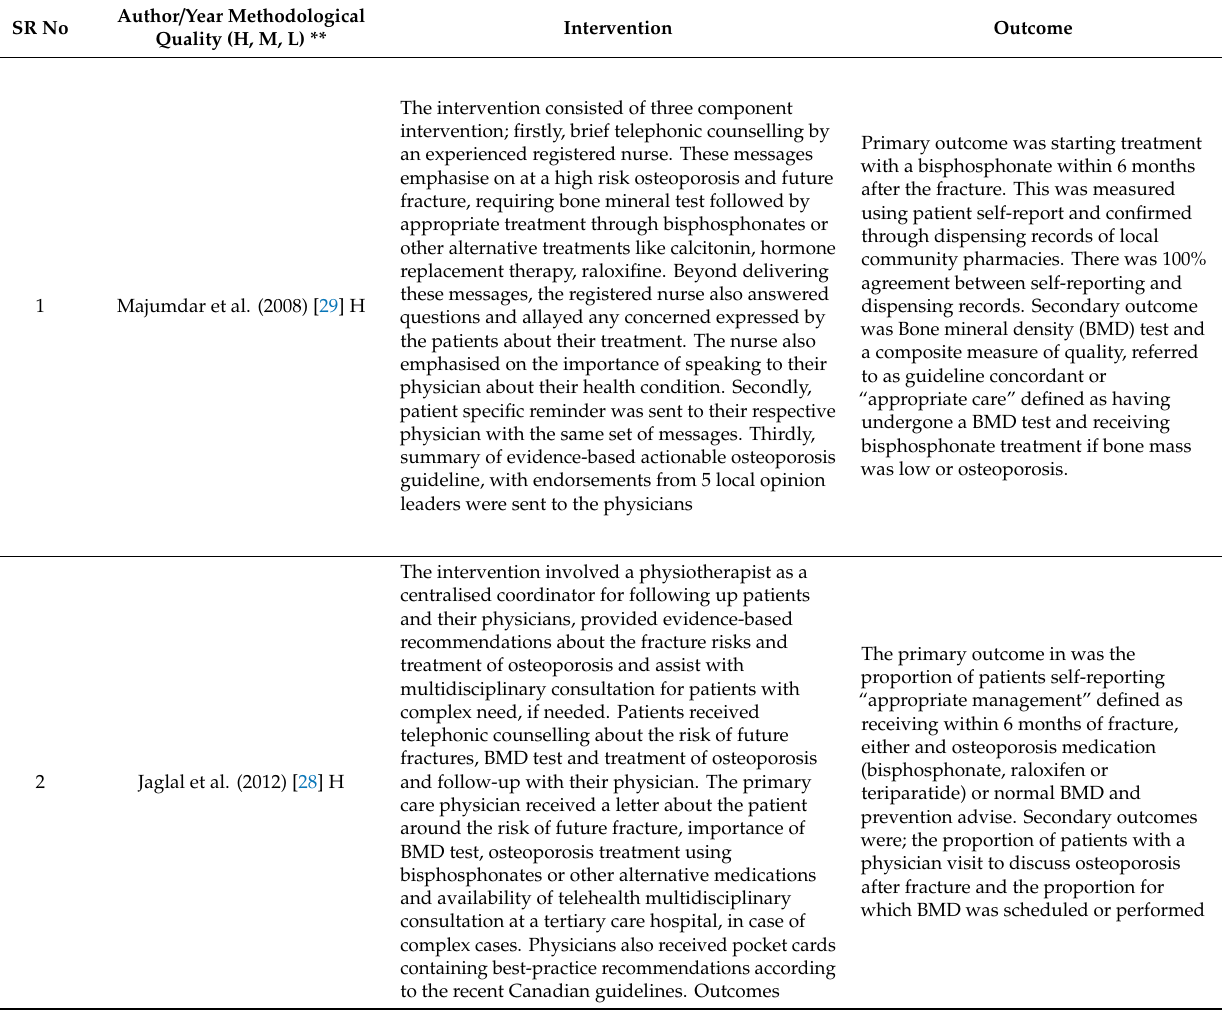
Table 2. Meta-analysis: (Targeted patient communication with primary care physician support